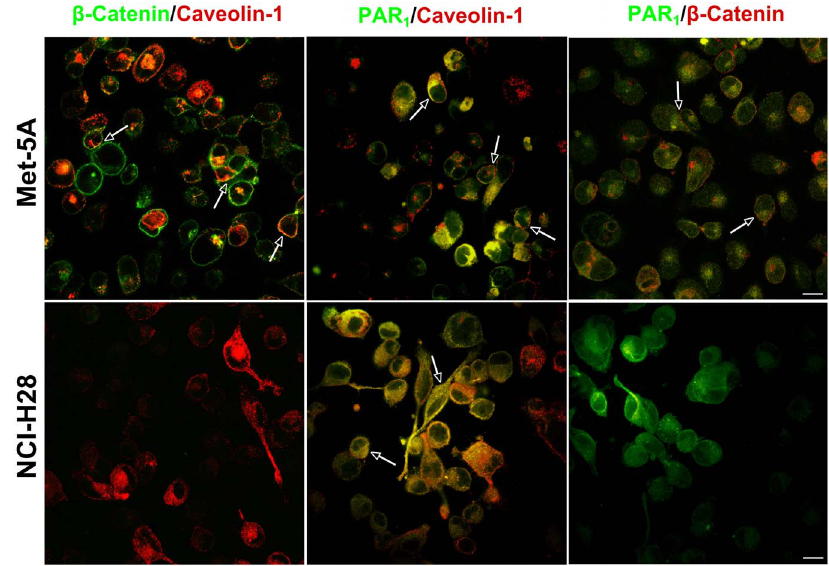
Figure 8. Double immunofluorescence labelling of caveolin-1 and PAR 1 in Met-5A and NCI-H28 cells. Double labelling was performed by incubating antibodies as follow: anti-PAR 1 and anti-caveolin-1; anti-PAR 1 and rabbit polyclonal anti- b -catenin; mouse monoclonal anti- b -catenin and anti-caveolin-1. To visualize double fluorescent staining, cells were incubated with Alexa Fluor 488- and Alexa Fluor 568-labeled goat anti-mouse and anti-rabbit antibodies as described in Materials and Methods. The images shown are representative of many cells examined in two independent experiments. The yellow stain indicates protein proximity (see arrows). All images were analyzed using the ImageJ program [34]. PCC values are expressed as mean 6 SEM of six examined area. PCC value for PAR 1 /caveolin-1 colocalization was 0.77 6 0.05 and 0.84 6 0.03 in Met-5A and NCI-H28 cells, respectively. PCC values for PAR 1 / b -catenin and caveolin-1/ b -catenin colocalization in Met-5A cells were 0.70 6 0.02 and 0.55 6 0.04, respectively. Scale Bar: 10 m